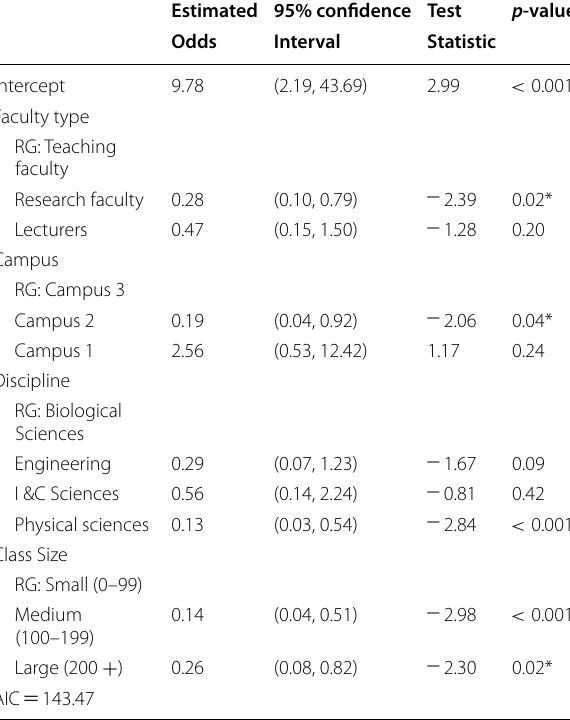
Table 8 Final logistic regression model for active-learning